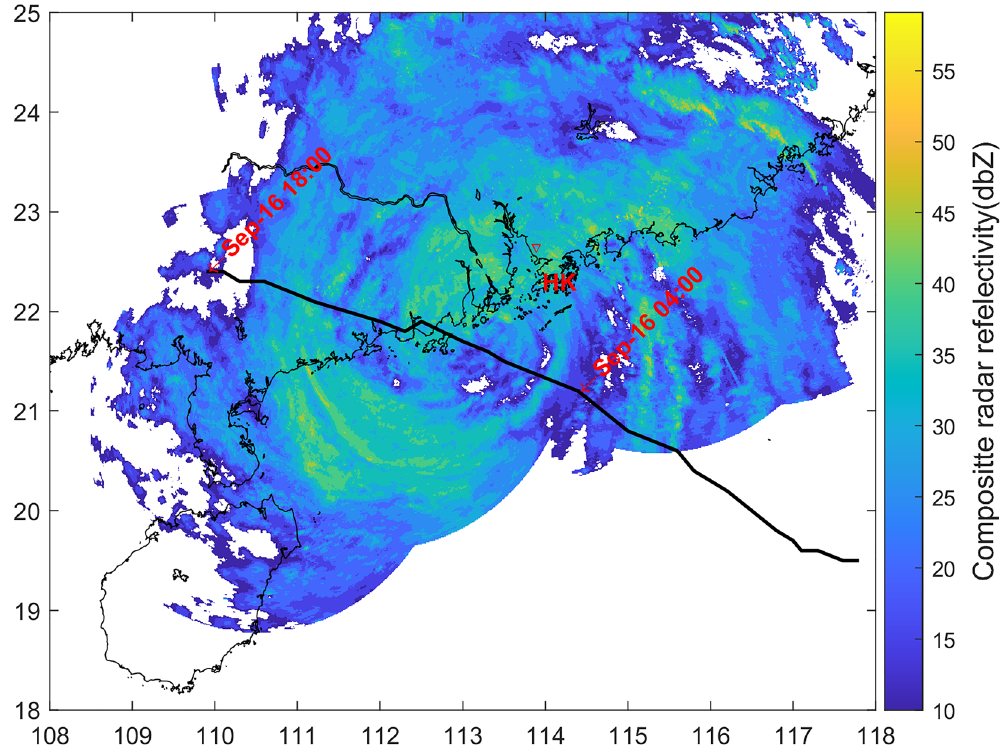
Figure 1. Plots of radar reflectivity composite at 07:00 UTC on September 16 when the tower was closest to the typhoon center, and real-time track (bold solid line) of Typhoon Mangkhut (1822) in the coastal area of South China from 14:00 UTC on September 15, 2018, to 18:00 UTC on September 16, 2018. The storm track data was obtained from the National Meteorological Centre of China. The circle and x symbols denote the location of the Shenzhen Meteorological Tower. HK represents